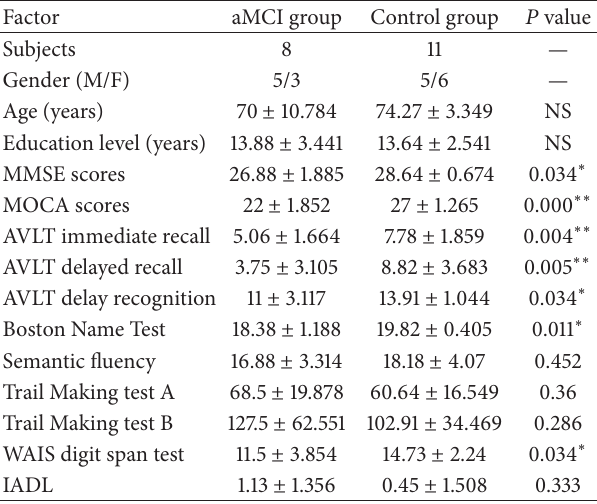
Table 1: Demographic characteristics and neuropsychological test scores and 𝑃 values between aMCI and control groups in T2DM.